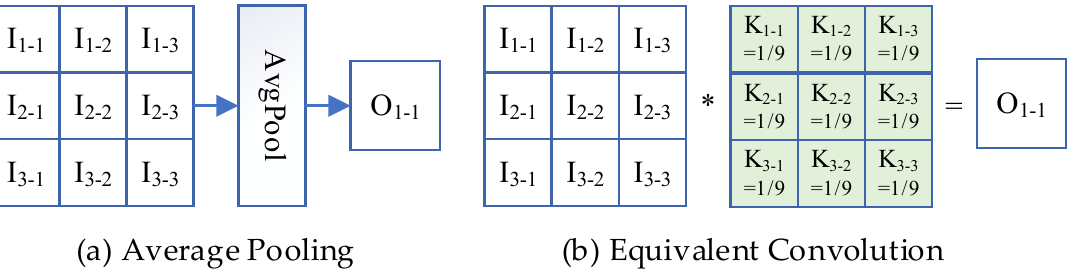
Figure 4. Average pooling is transformed into equivalent convolution.